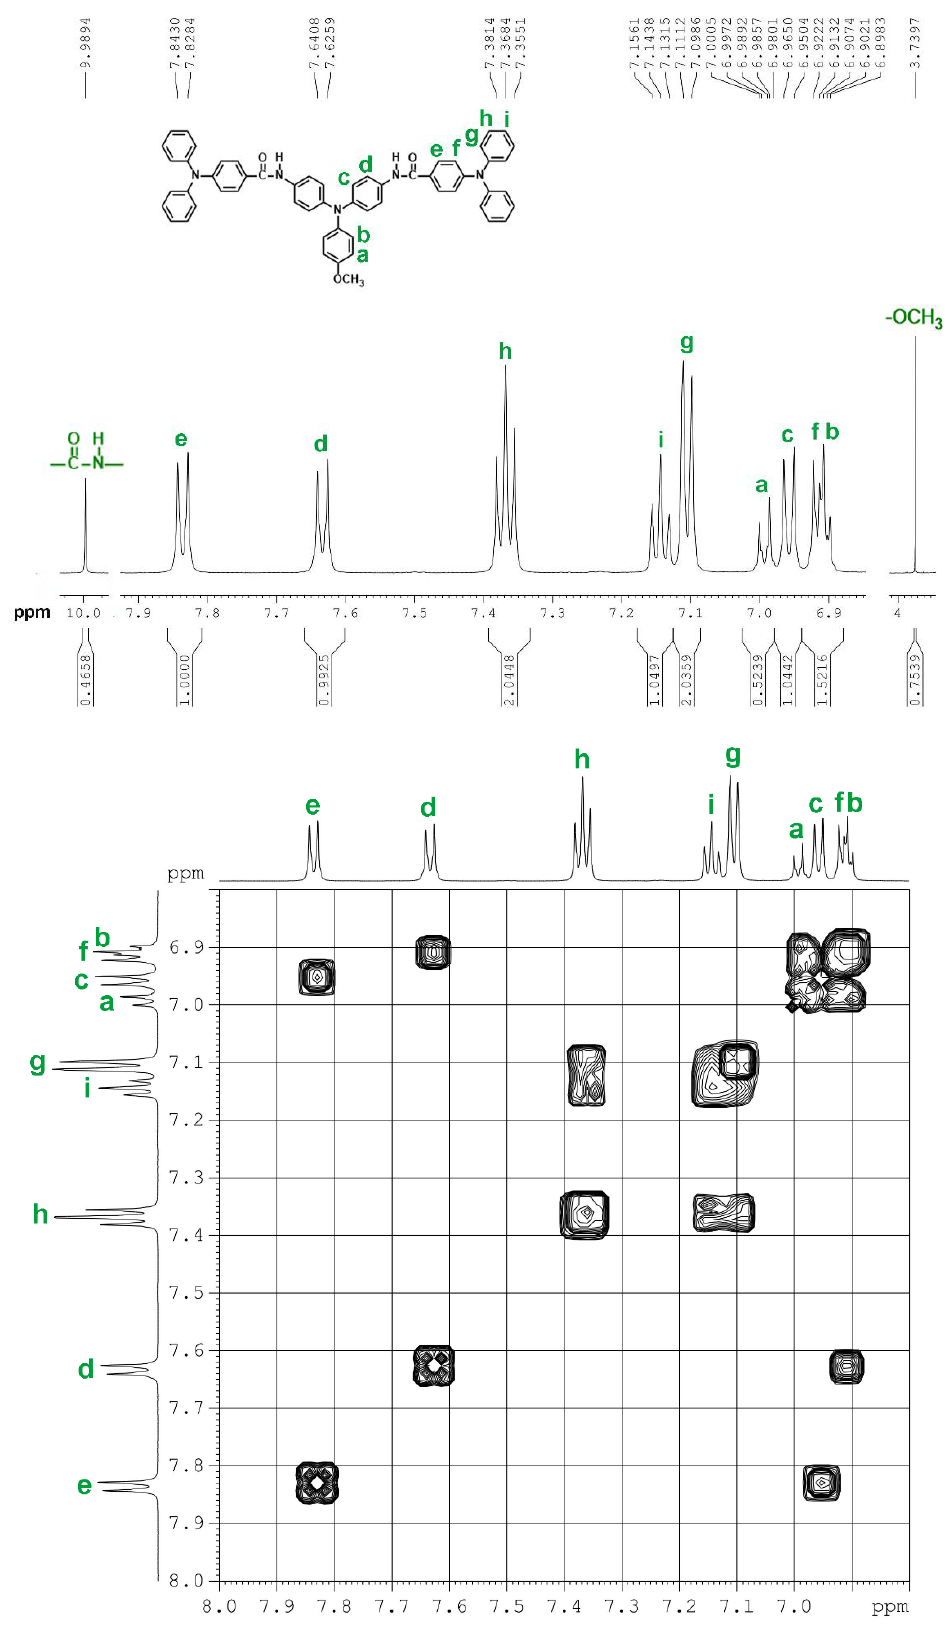
Figure 1. 1 H NMR and H–H correlation spectroscopy (COSY) spectra of MeOTPA-(TPA) 2 in dimethyl sulfoxide (DMSO)- d 6 .